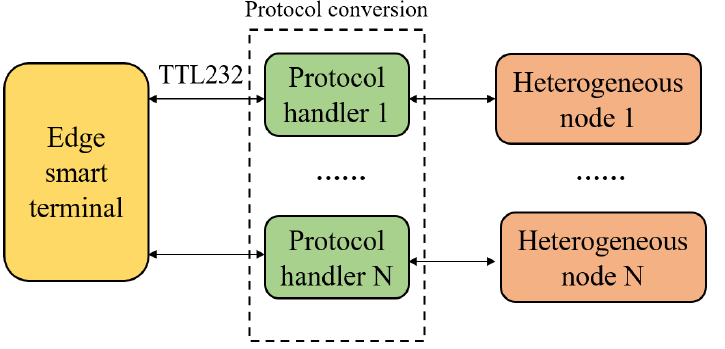
Figure 4. Heterogeneous nodes networking framework.